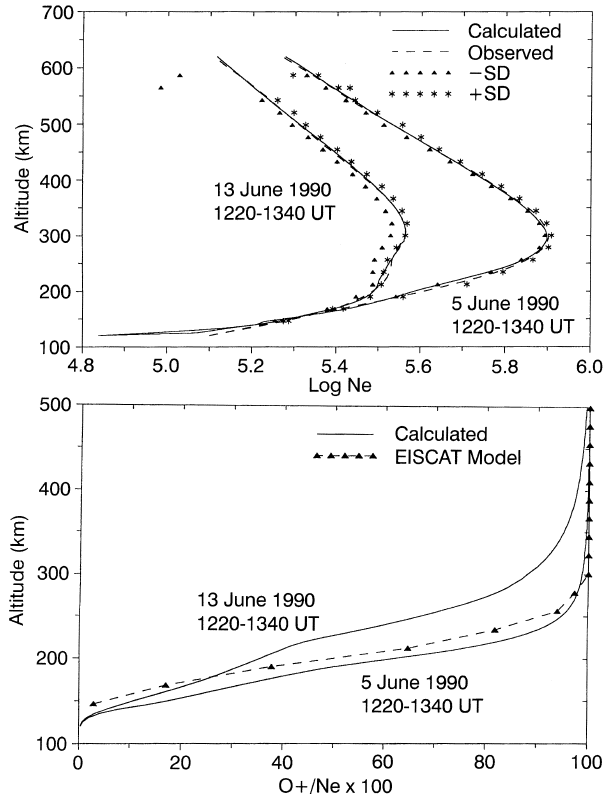
Fig. 5. Same as Fig. 3 but for geomagnetically quiet (5 June 1990) and disturbed (13 June 1990) days